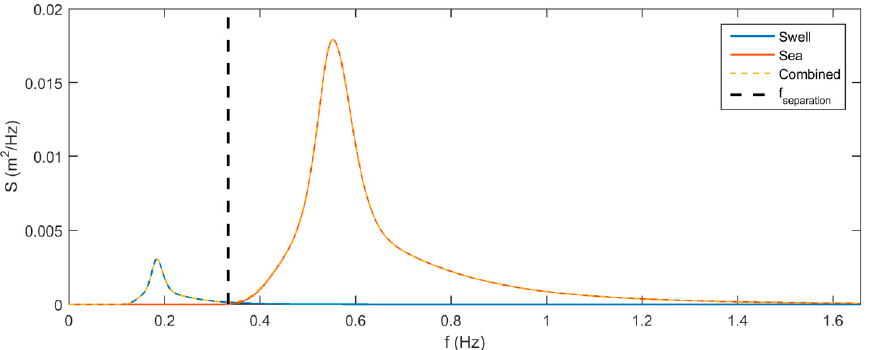
Figure 4. Double peaked spectrum and separation frequency (for Test S3-02).